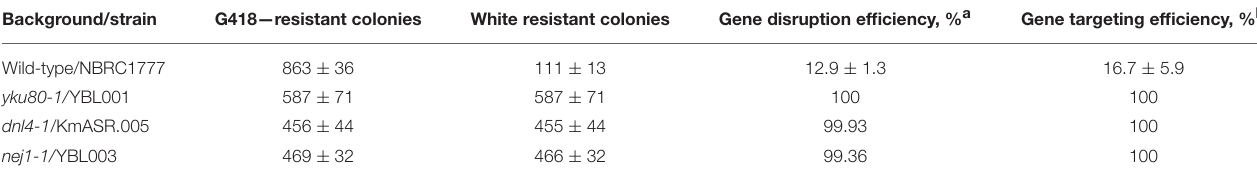
The data are presented as the mean ± s.d of three replicates. a The percentage of white colonies with respect to all blue and white colonies; b Colony PCR was performed on eight white colonies per replicate to check for correct integration of the YFP cassette at LAC4.